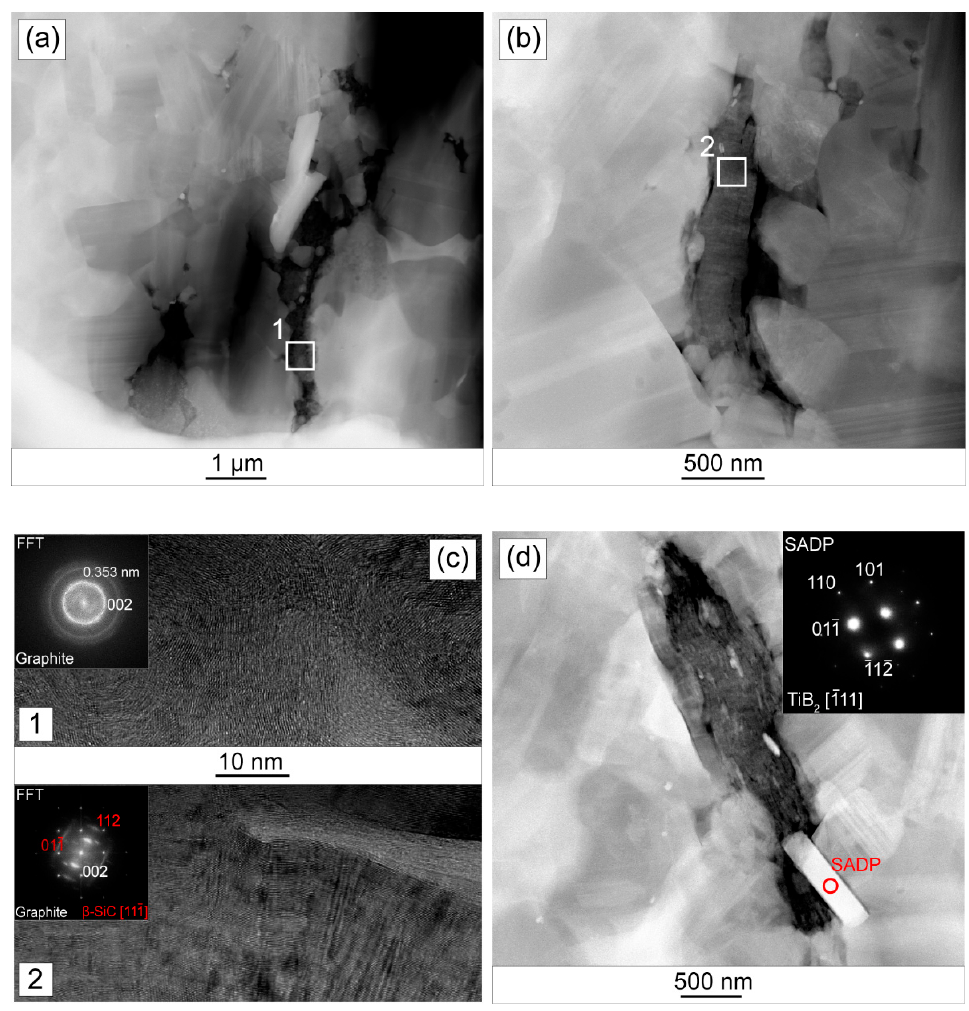
Figure 6. TEM analysis of SiC-2 wt.% Ti 3 C 2 T x composites ( a ) HAADF scanning transmission electron microscope (STEM) image of reinforcing phase; ( b ) HAADF scanning transmission electron microscope (STEM) image of the reinforcing phase; ( c ) HRTEM image of area 1 and 2 with the Fourier transform; ( d ) HAADF scanning transmission electron microscope (STEM) image of the observed particles with the electron diffraction.